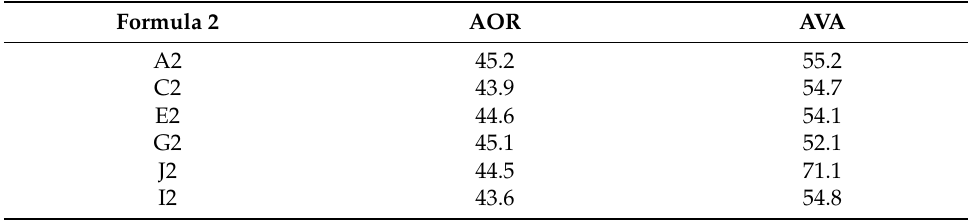
Table 8. The flow ability of powders prepared by Formula 2.